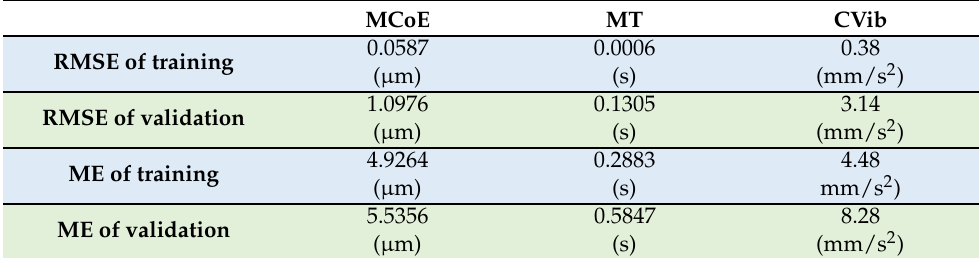
Table 3. Training and validation results for the artificial neural network (ANN) model: the maximum contour error (MCoE) and machining time (MT) and corner vibration (CVib). MCoE MT CVib 0.0587 RMSE of training ( µ